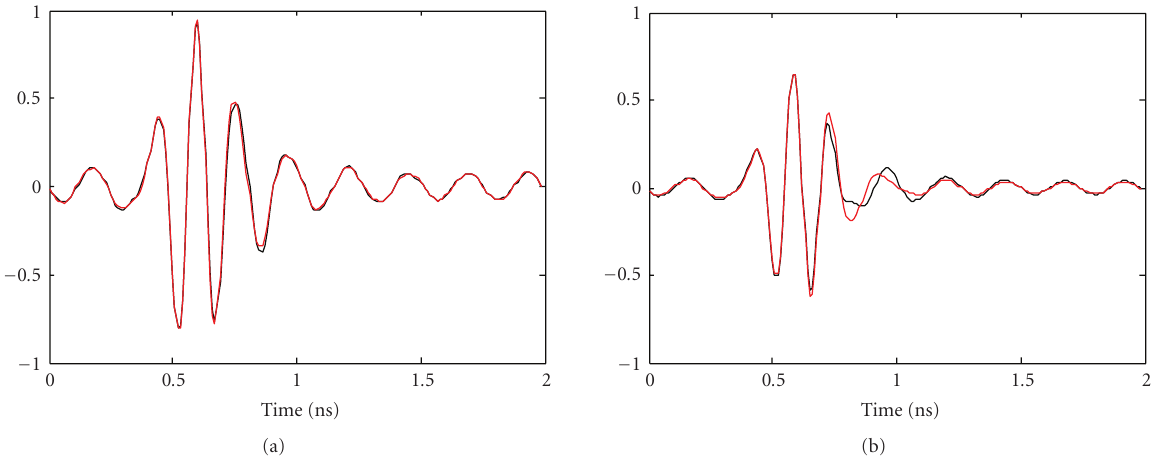
Figure 18: Expected radiated waveform (black line), SC approximation (red line) at (a) ϕ = 90 ◦ and θ = 90 ◦ , (b) θ = 30 ◦ .